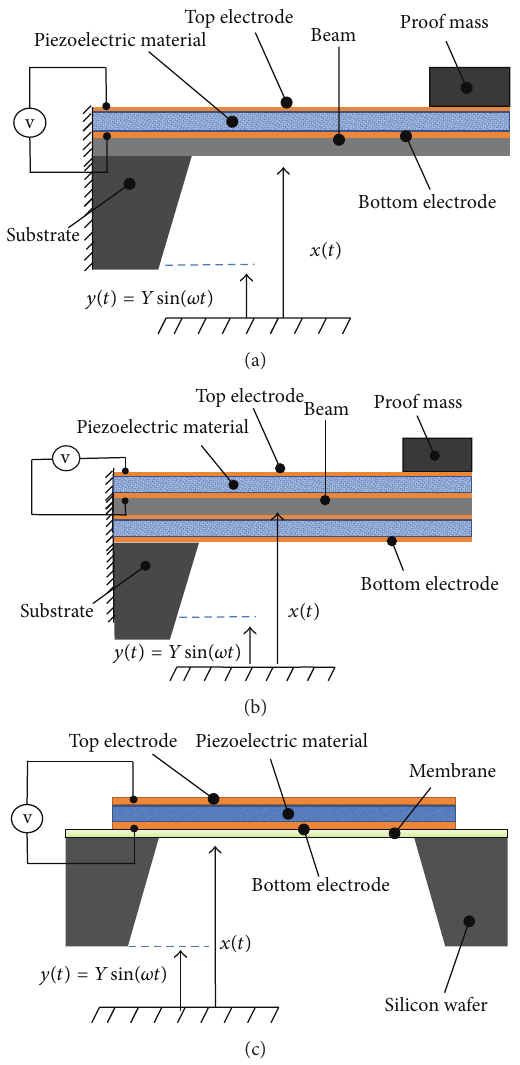
Figure 2: Schematic diagram of various PE-VEHs: (a) unimorph cantilever type PE-VEH, (b) bimorph cantilever type PE-VEH, and (c) membrane type piezoelectric